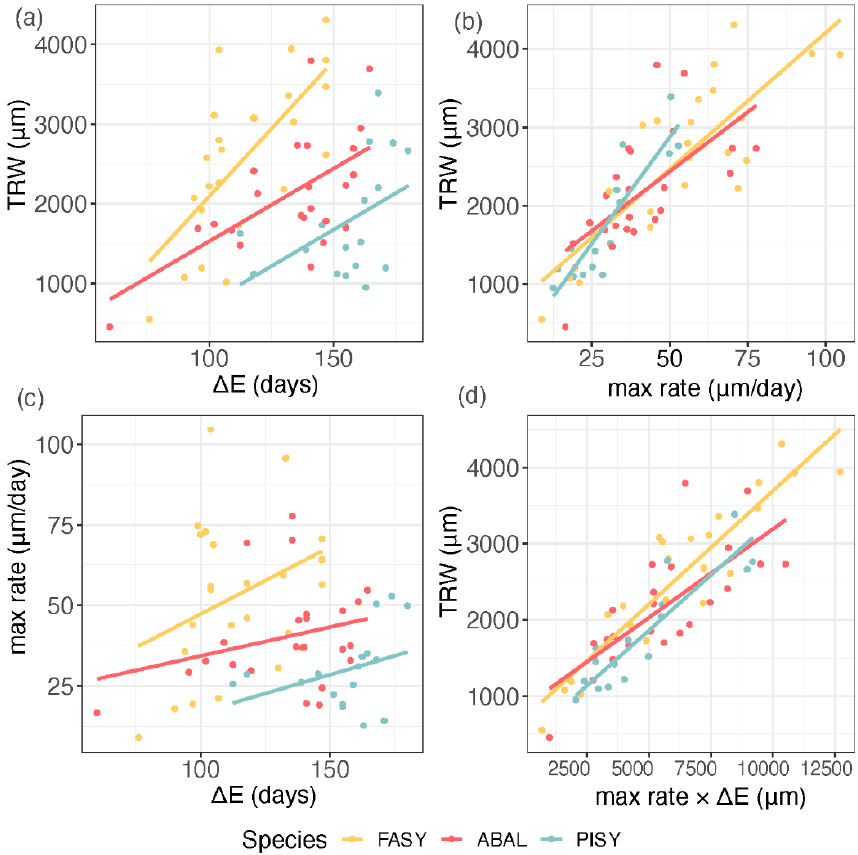
Figure 8. Scatterplots with species-wise linear relationships; ( a ) tree-ring width (TRW) and radial growth duration ( Δ E), ( b ) tree-ring width and maximum daily growth rate ( μ m/day), ( c ) radial growth duration and maximum daily rate, ( d ) tree-ring width and product of rate and duration.